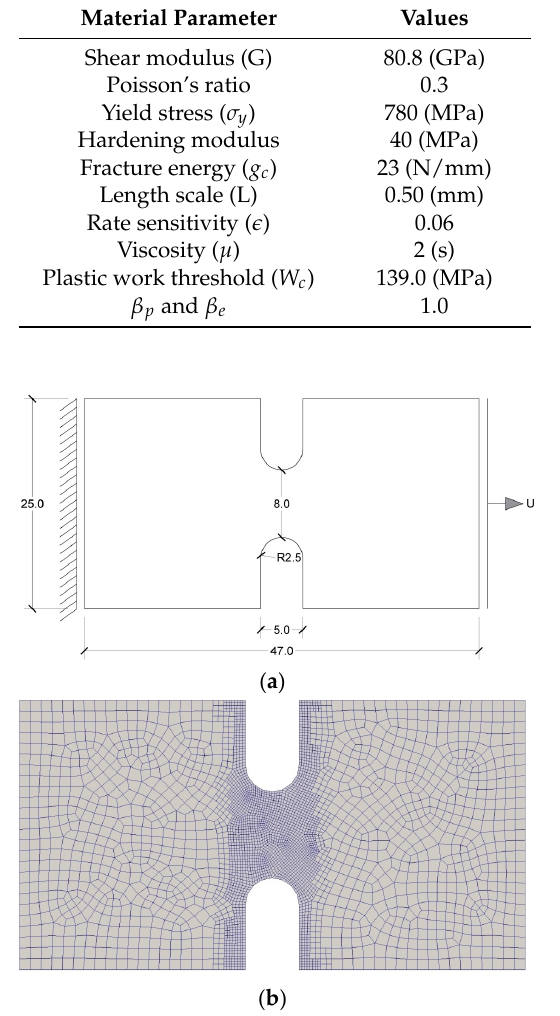
Figure 8. The U ‐ notched plane strain sample: ( a ) the geometry and associated dimensions in mm and ( b ) the finite element discretization.